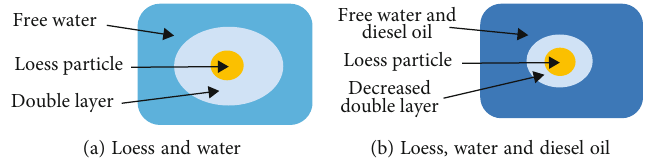
Figure 8: Schematic diagram of the e ff ect of diesel oil on the thickness of double layer. Table 5: Results of uncon fi ned compressive strength tests under the two di ff erent modes of oil contamination. Modes of oil contamination